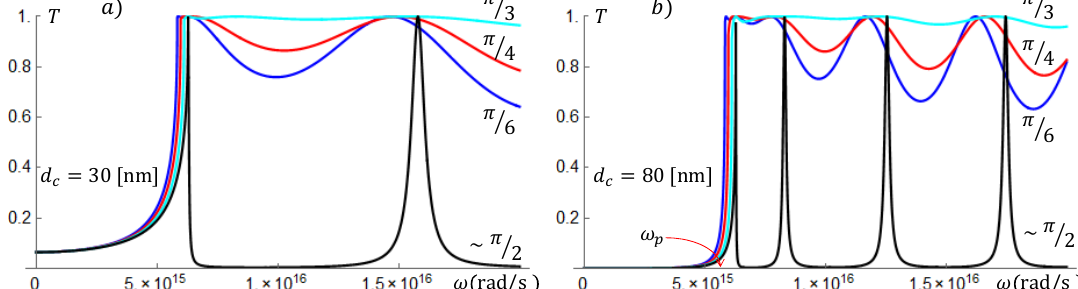
Figure 2. Transmittance as a function of the frequency through a single slab of silver with thickness d c = 30 nm ( a ) and d c = 80 nm ( b ), for incidence angles θ i = π /6, π /4, π /3, and slightly less than π /2. For the slab thicknesses considered here, the EM field is highly attenuated below the plasma frequency ω p = 5.75 × 10 15 rad/s and oscillating for ω > ω p . Near the incidence angle of π /2, the narrow and isolated resonances correspond to localized surface plasmons. Notice that as the incidence angle grows, the resonances move towards the isolated surface plasmon